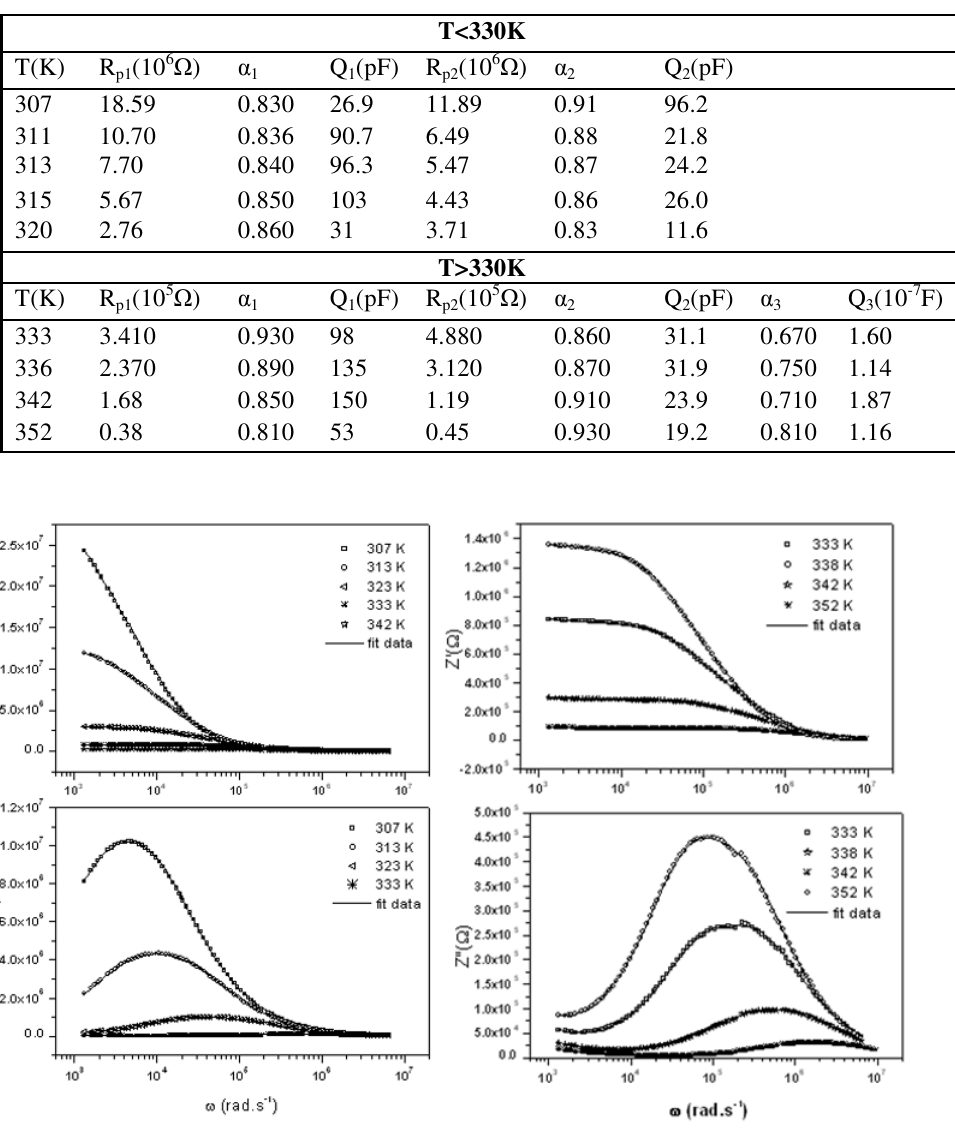
2 H 10 N 2 Cd(SCN) 2 (Cl) 2 at various